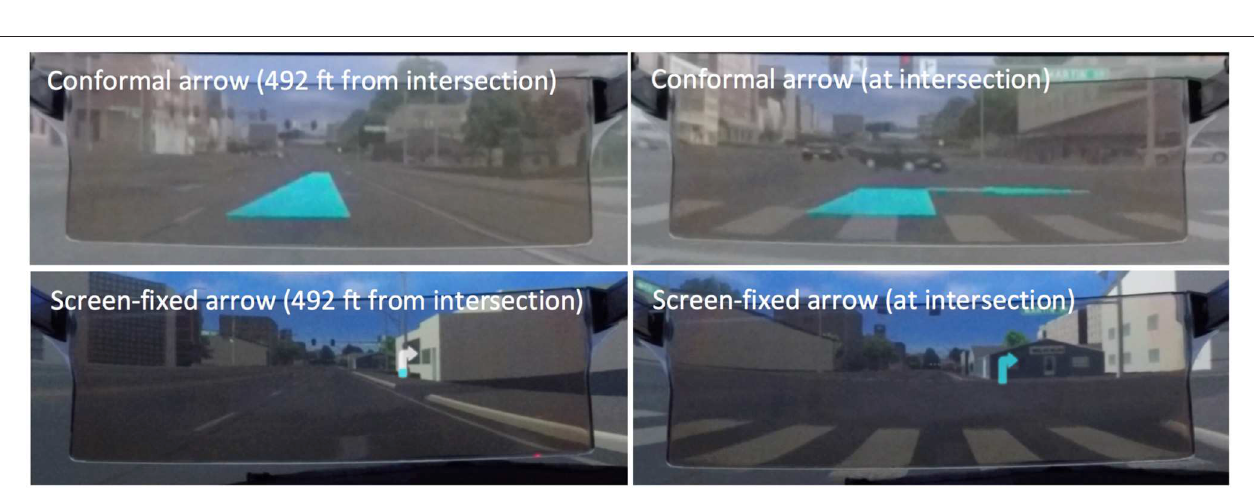
FIGURE 5 | The user study examined two HUD display conditions: a conformal arrow integrated into road scene (top) , and, a screen-fixed arrow which filled as drivers approached turns (bottom) . For each, the initial state of the graphic appeared at 392 feet from the interaction (left panels), and disappeared after participants traversed intersections (right